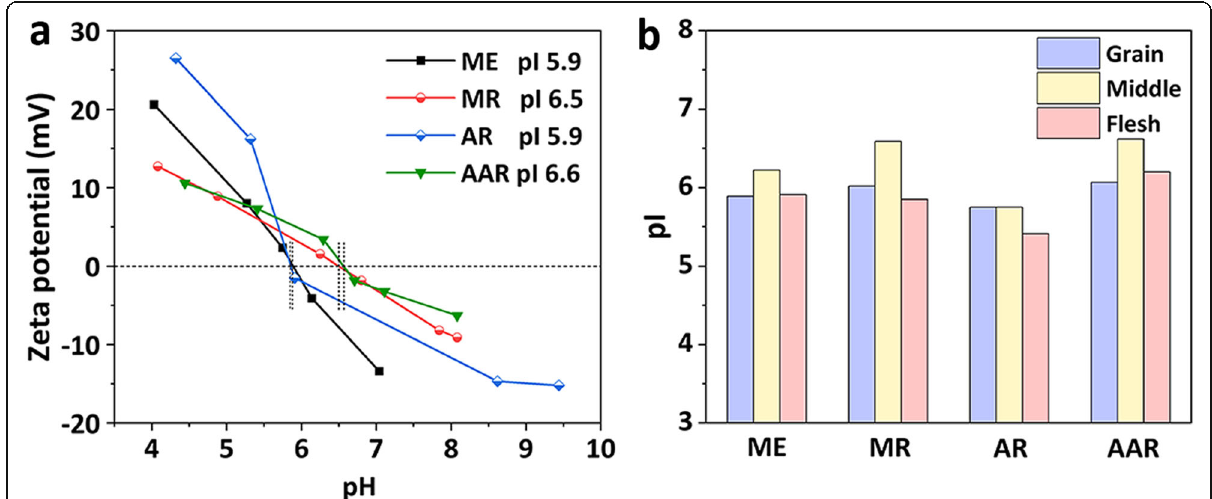
Fig. 3 pIs of the entire wet white ( a ) and each layer of wet white ( b ) retanned with single retanning agent